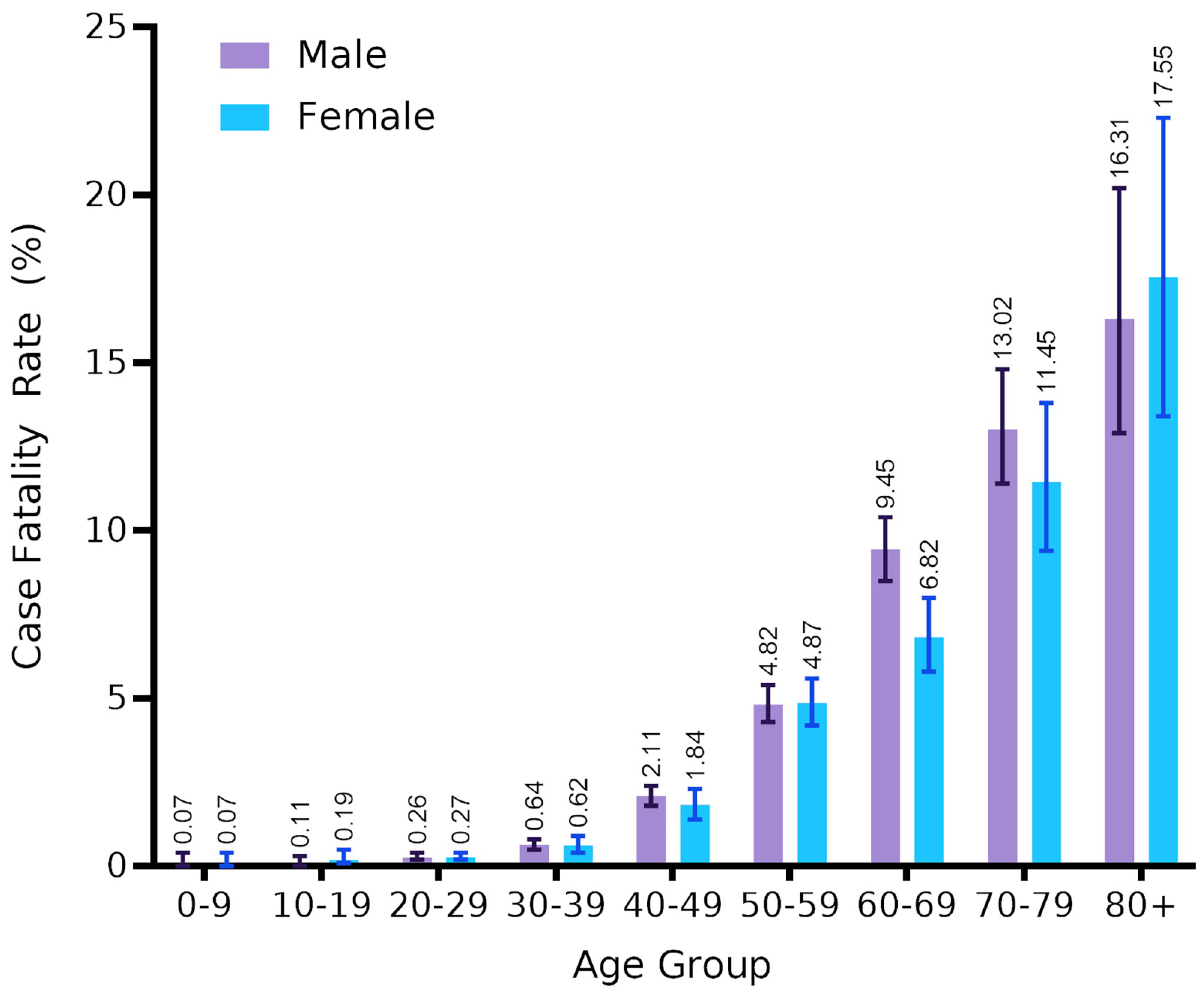
Fig 4. Case fatality rate COVID-19 cases stratified by age and sex in Karnataka, India up to 21 July 2020 (n-71068). Bars represent mean CFR for that subgroup (value shown above bars) with error bars showing the 95% confidence intervals.